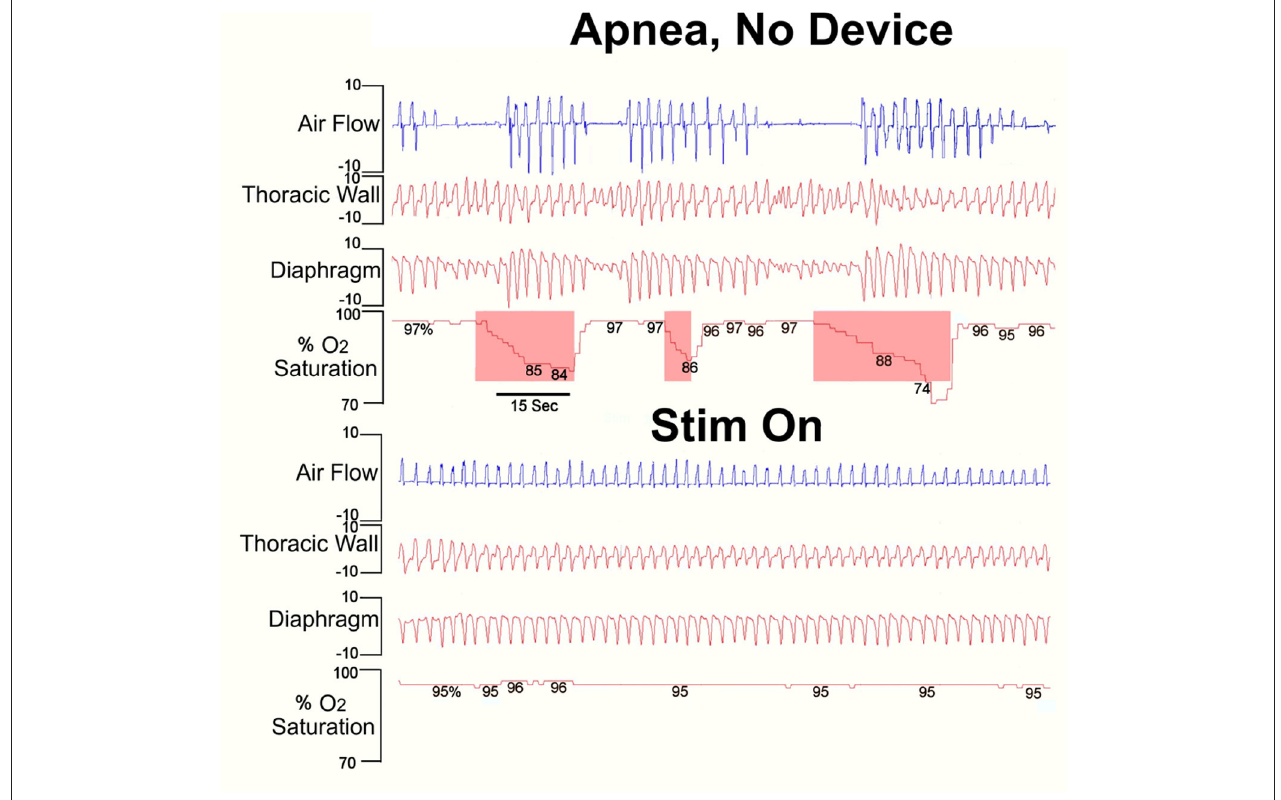
FIGURE 3 | Stimulation of proprioceptive fibers of the foot of a pediatric (4 years) CCHS patient without (top) and with the device (Stim On). Note the decline in O 2 saturation (shaded O 2 saturation areas following cessation of breathing efforts) during no stimulation, and the complete abolition of periodic breathing and restored saturation with stimulation. Clinical data courtesy of Dr. M. Woo [Derived from (